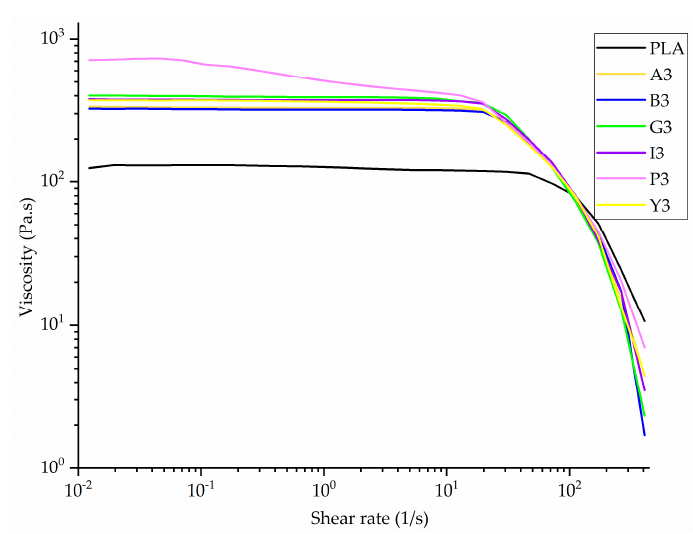
Figure 8. Rheogram of PLA and its composites containing 3% (w / w) of each additive.